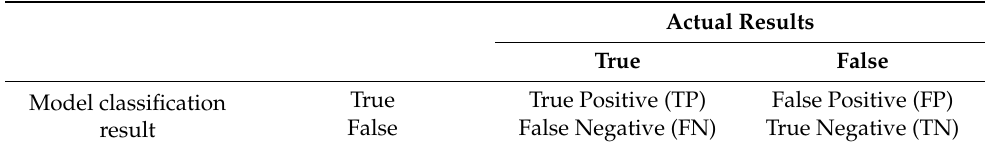
Actual Results True False